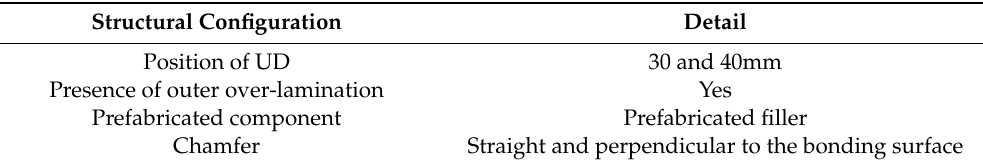
Table 2. Structural configurations of the PUD model.